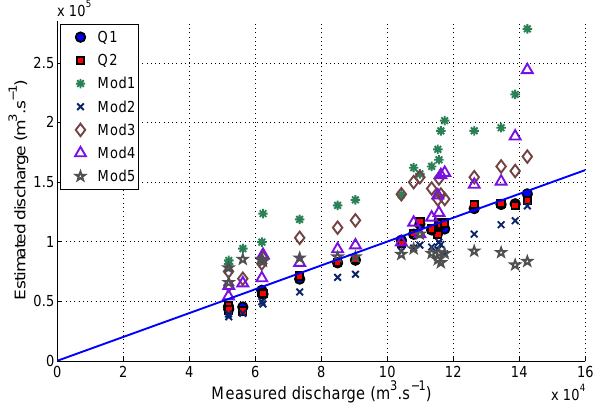
Fig. 4. Comparison of the estimated discharge with the ADCP dis- charge measurements for the Manacapuru dataset.